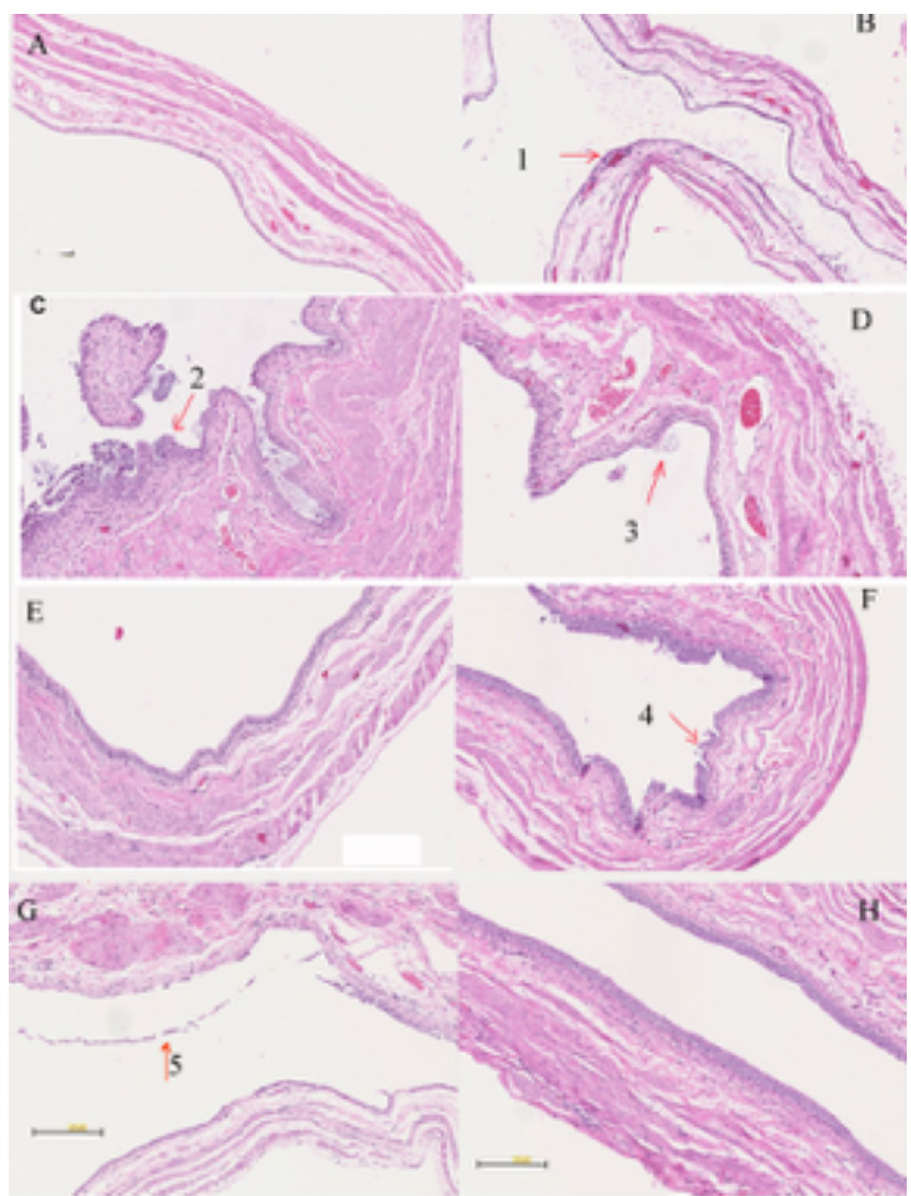
Figure 5. Histology images (H&E stained). ( A ) Normal Bladder Control; ( B ) UTI infection ( C ) MB + KI dark; ( D ) MB PDT; ( E ) MB + KI + PDT; ( F – G ) MB + KI + PDT with some injury of surface epithelial cells. G. MB + KI + PDT 2 weeks after inoculation. Bar 200 μ m. (Arrow 1, 2 and 3 show intracellular bacterial communities, arrows 4 and 5 show urothelial